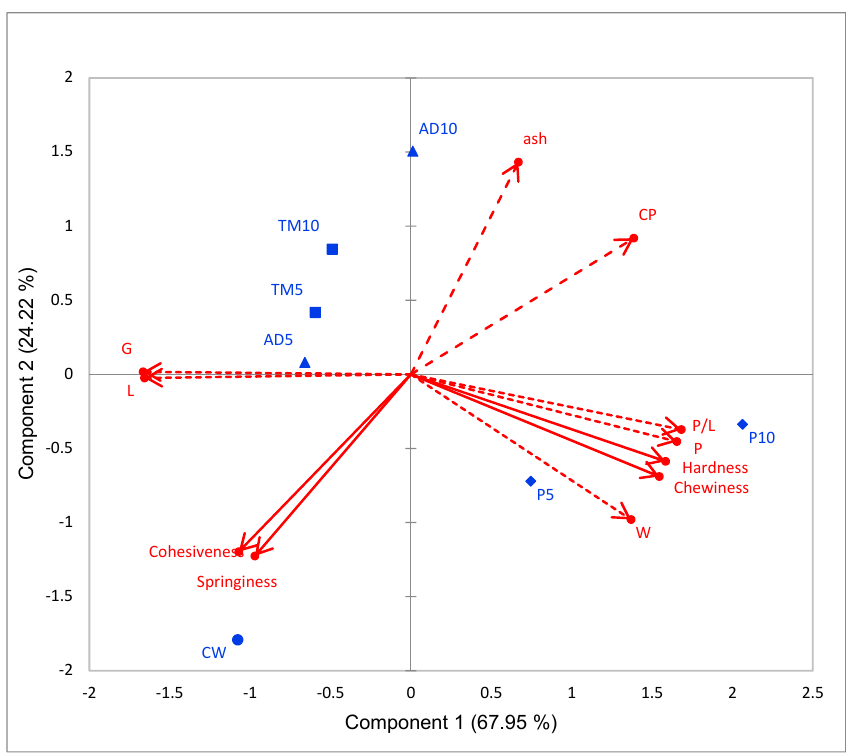
Figure 4. Biplot of principal component analysis (PCA) scores of samples and loadings of variables (rheological and compositional). CW: Control; P5: Pea 5%; P10: Pea 10%; TM5: T. molitor 5%; TM10: T. molitor 10%; AD5: A. diaperinus 5%; AD10: A. diaperinus 10%.